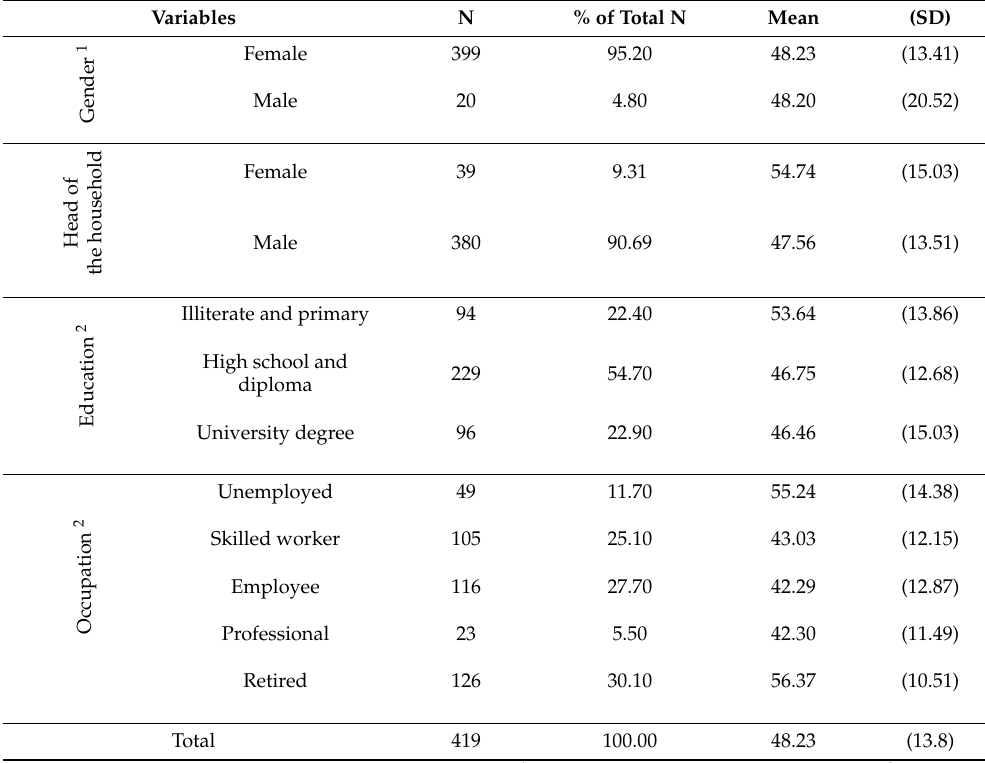
Table 2. Demographic and socioeconomic summary of the studied